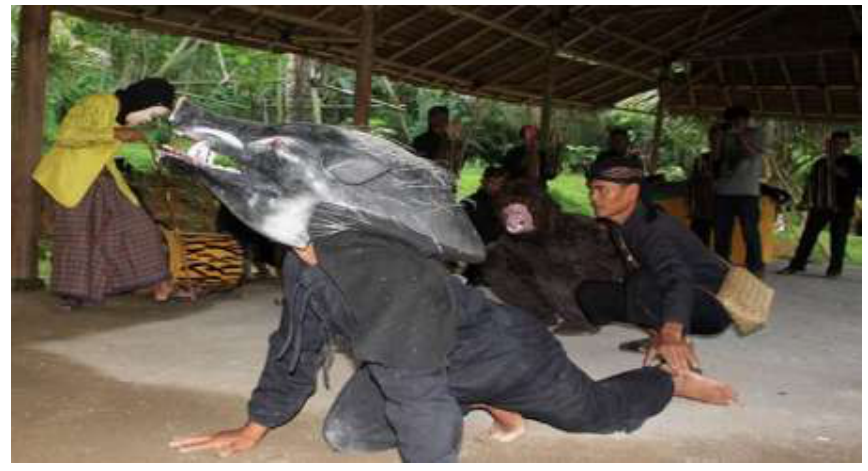
Figure 6. Badud Art